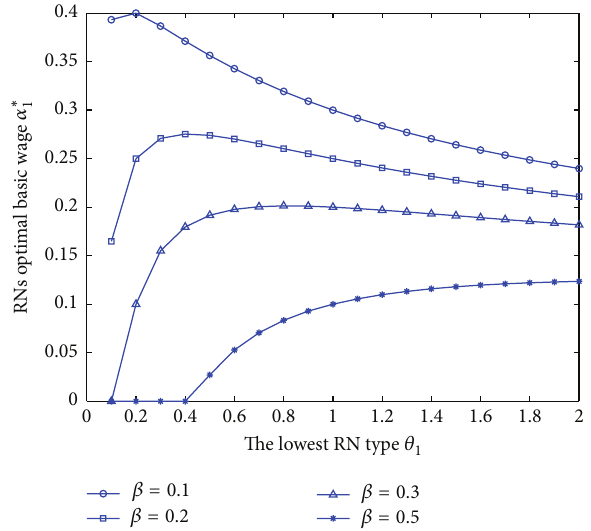
Figure 2: Source’s optimal utility 𝑈 ∗ 𝑆 versus the equivalent profit 𝜌 for fixed 𝛽 1 = 0.1 , 𝑁 1 = 2 , and 𝑈 = 0.1 .